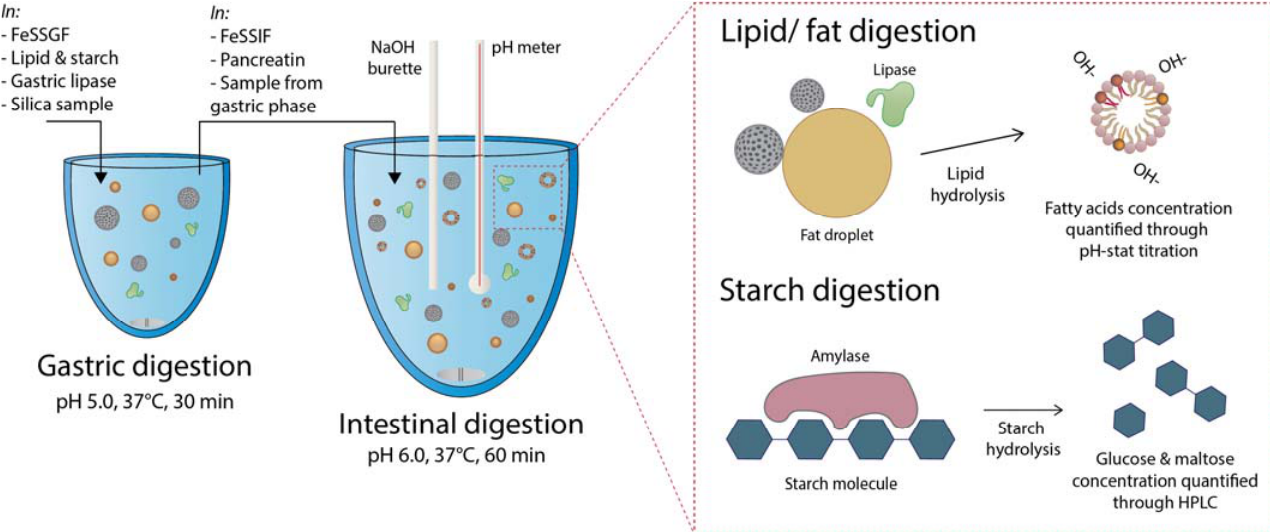
Figure 2. Schematic overview of the in vitro digestion approach.